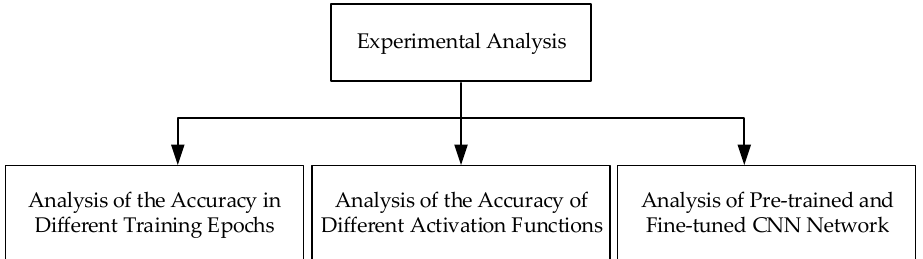
Figure 9. Flow diagram of the experimental analysis.